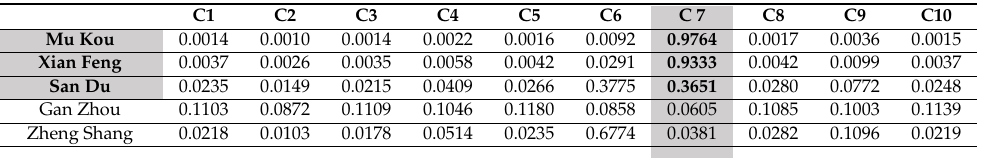
Table 5. Clustering results after direct FCM clustering (C represents Cluster).